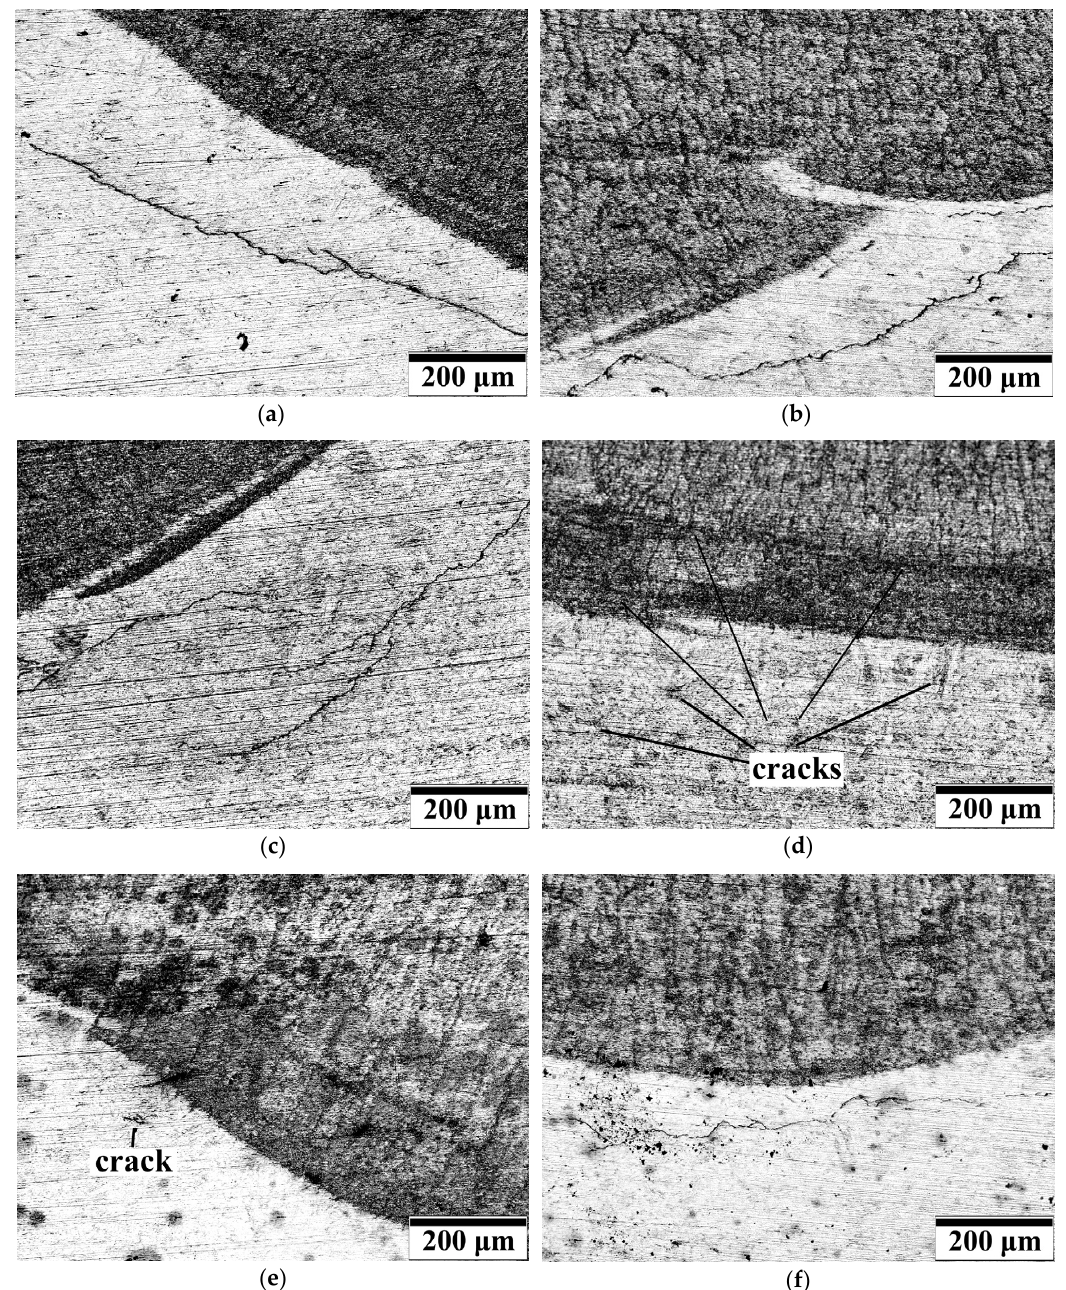
Figure 9. Results of microscopic testing, specimen welded by: ( a ) E 38 0 R11 without coating, ( b ) liquid foil, ( c ) impregnate for concrete, ( d ) silicone spray, ( e ) paraffin wax, ( f ) underwater electrode.